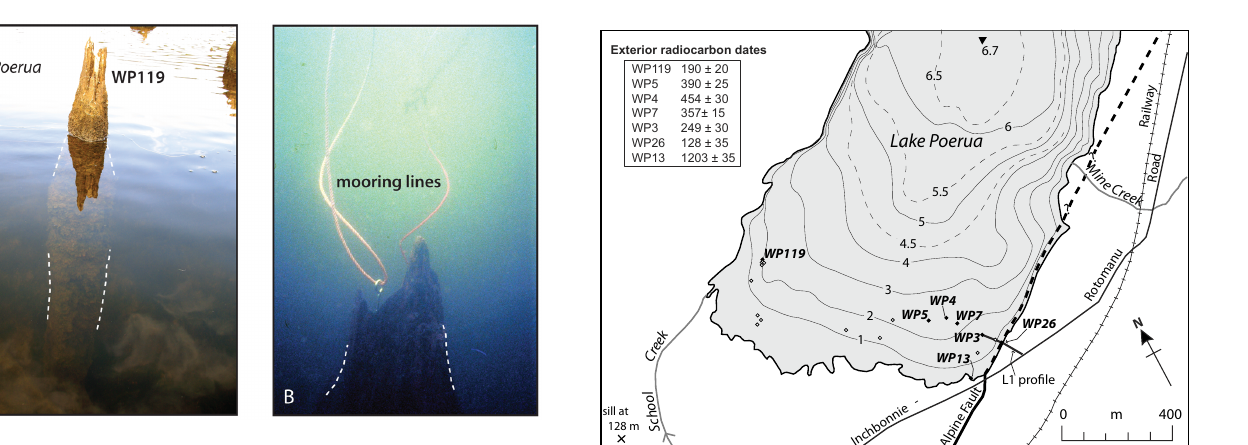
mate of when the tree died. Kahikatea stump WP26 had